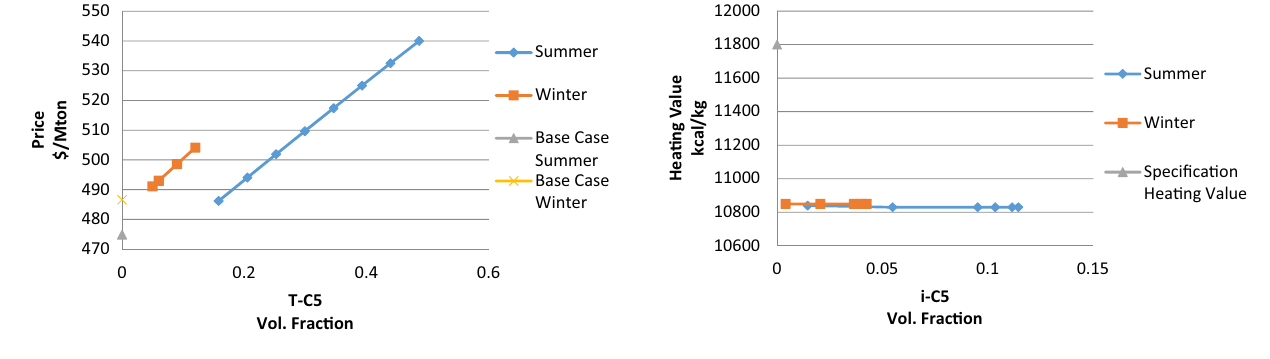
Fig. 30 Effect of adding i-C5 and 20 vol% DME on LPG heating